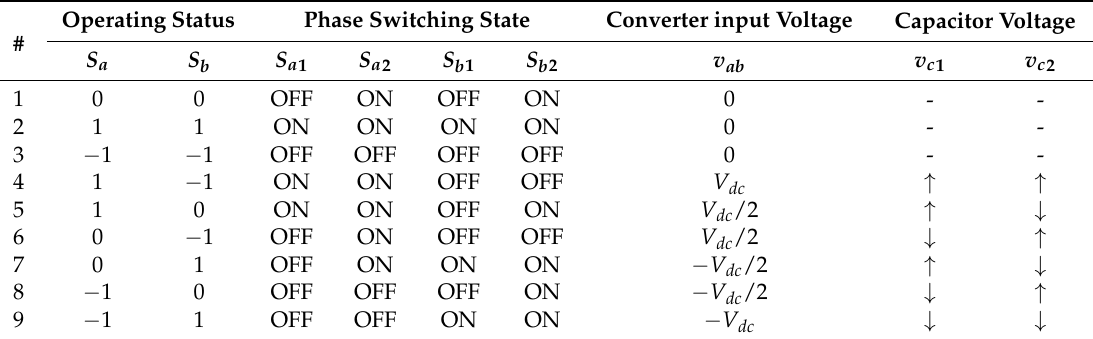
Table 1. Nine operating states, phase switching state, upper device switching status, and converter input voltage of single-phase three-level NPC